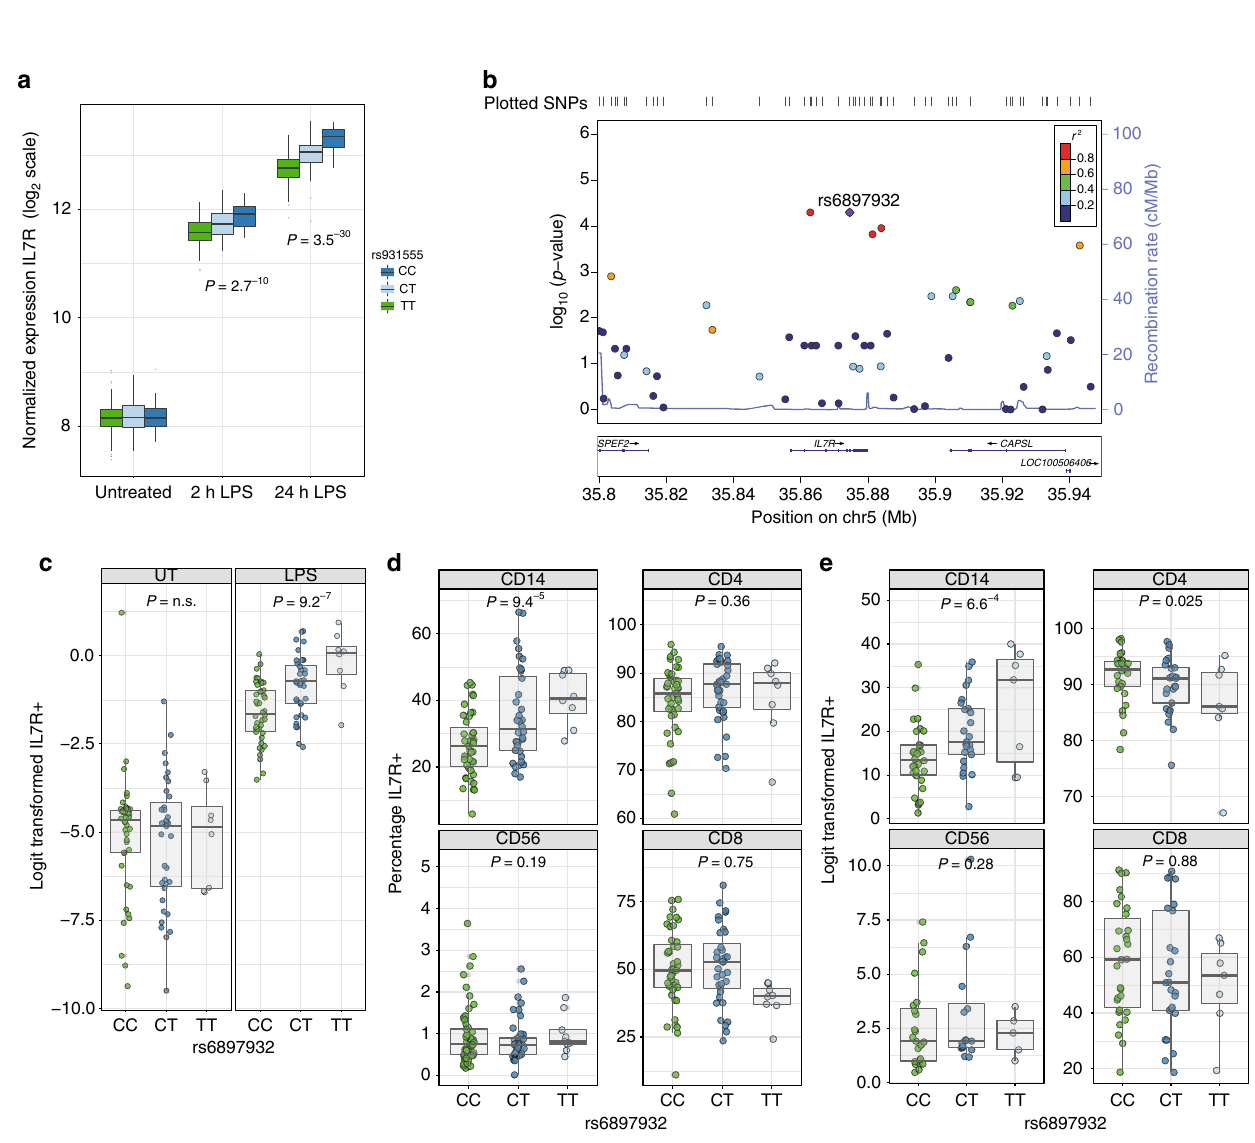
Fig. 2 rs6897932 speci fi cally regulates monocyte cell surface IL7R levels. a Microarray data demonstrating eQTL to IL7R noted at rs931555 after both 2 and 24 h treatment with LPS (2 h LPS: n = 261, 24 h LPS n = 322). b Local association plot for monocyte IL7R after exposure to LPS from positively selected monocytes demonstrates peak association to rs6897932 ( n = 84). c Batch corrected log values for surface IL7R from positively selected monocytes demonstrating signi fi cant effect of rs6897932 carriage after stimulation in comparison to baseline monocytes ( n = 84, ANOVA for linear model). d Surface IL7R in PBMCs across cell subsets after exposure to LPS. ( n = 87, Note a signi fi cant effect of rs6897932 on surface IL7R is only observed in CD14 + monocytes, ANOVA for linear model). e As per d but PBMCs treated with TNF for 24 h ( n = 62). Error bars show mean, IQR, min, and max. Source data are provided as a Source Data fi le